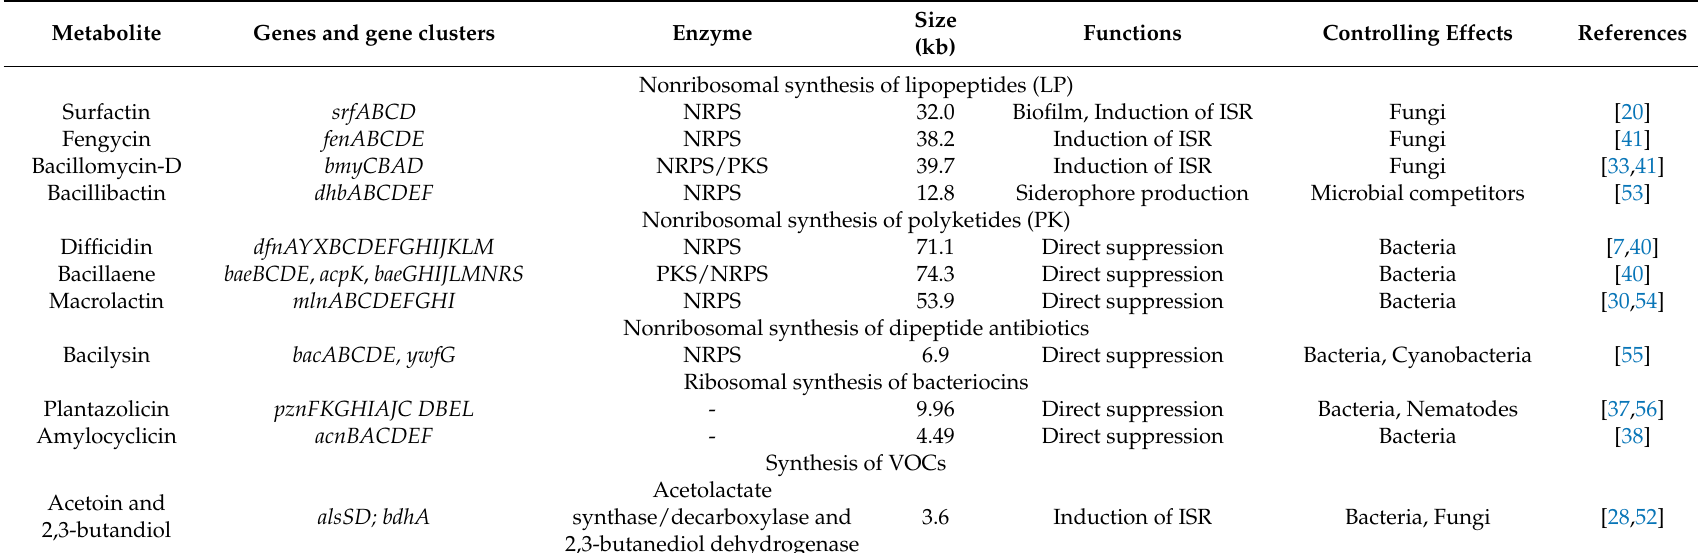
Table 1. Genes and gene clusters encoding for the secondary metabolites in B. velezensis.